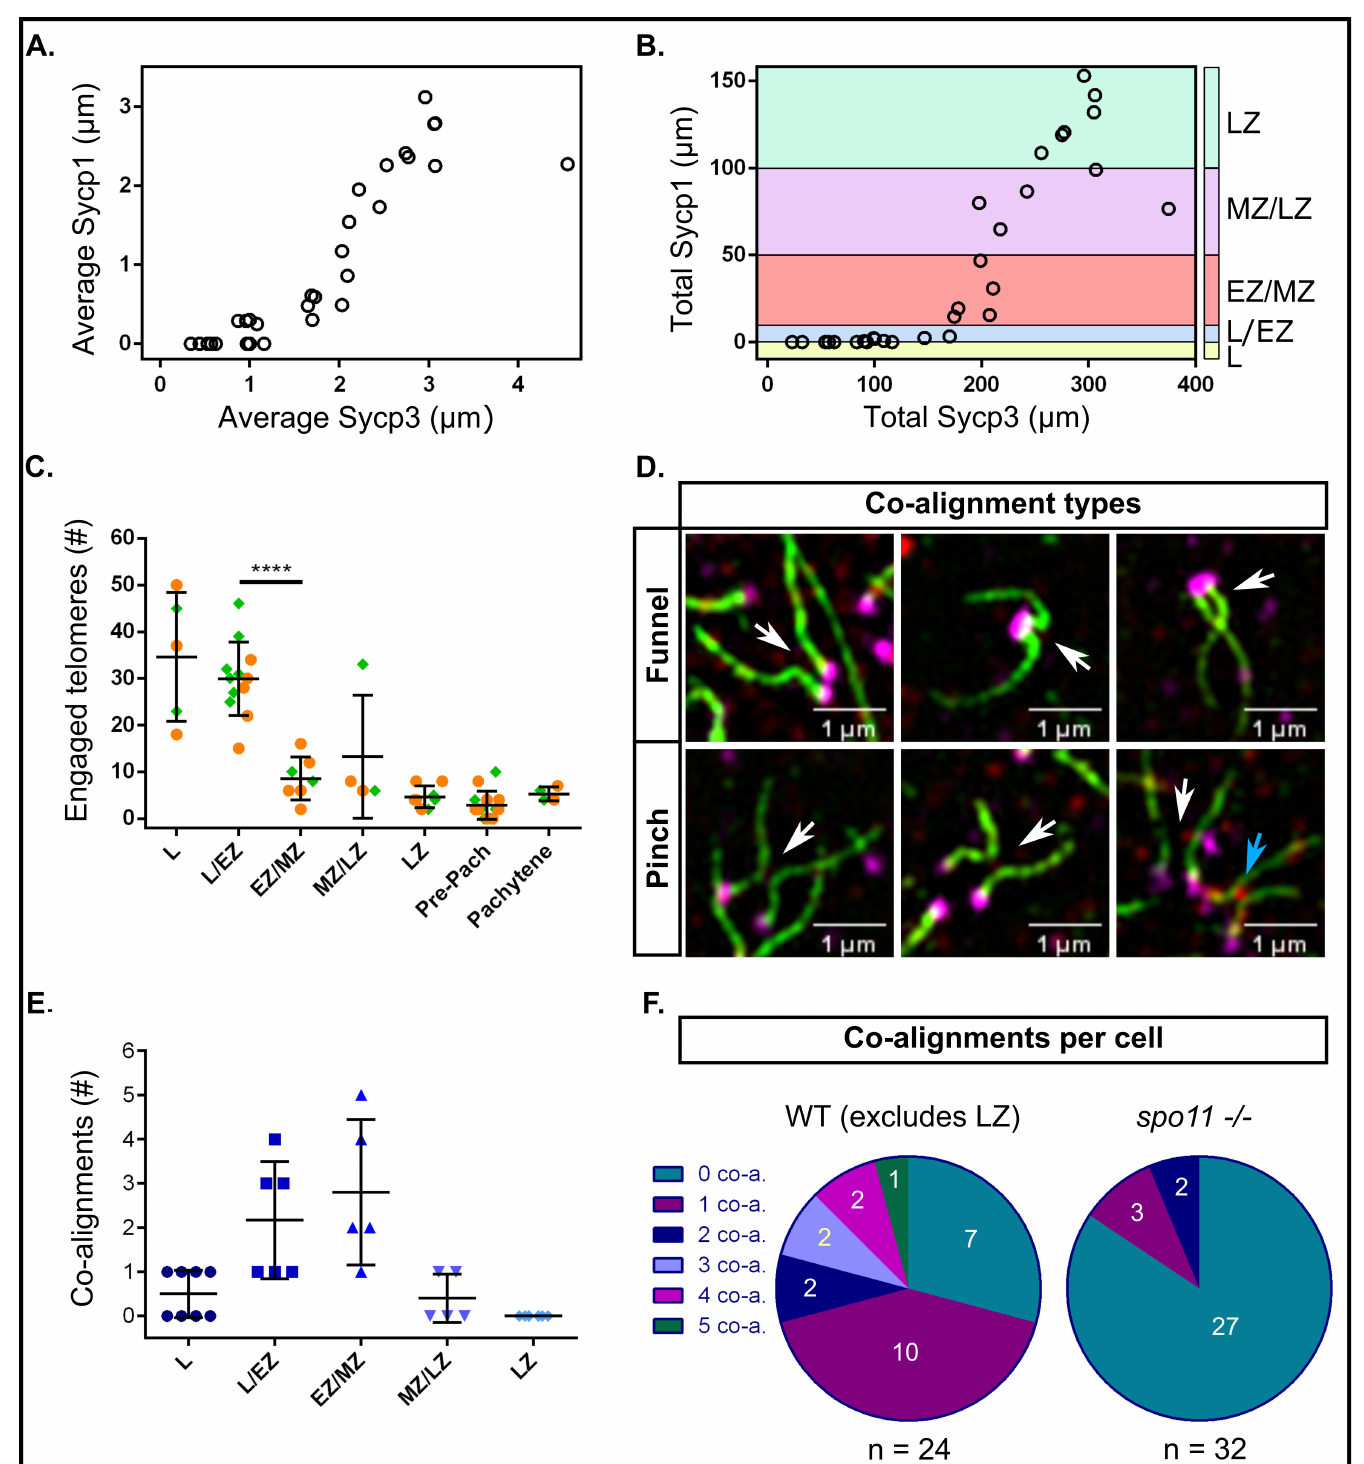
Fig 2. Measurements of Sycp3 vs. Sycp1 length, numbers of engaged telomeres, and numbers of co-alignments in male zebrafish meiosis I. A: Average Sycp3 length vs. average Sycp1 length. Each circle represents the average of all measurements in one nucleus (n = 30 nuclei). B: Total Sycp3 length vs. total Sycp1 length in the same cells shown in A. Stages of meiosis are defined by total length of Sycp1: leptotene (L, Sycp1 = 0 μ m; yellow); leptotene to zygotene transition (L/EZ, Sycp1 = 1–10 μ m; blue); early to mid-zygotene (EZ/MZ, Sycp1 = 10–50 μ m; pink); mid to late zygotene (MZ/LZ, Sycp1 = 50–100 μ m; purple); late zygotene (LZ, Sycp1 > 100 μ m; cyan). C: Numbers of engaged telomeres per cell, where one engaged telomere end is an Sycp3 line with its telomere associated with a potentially non-homologous telomere end.